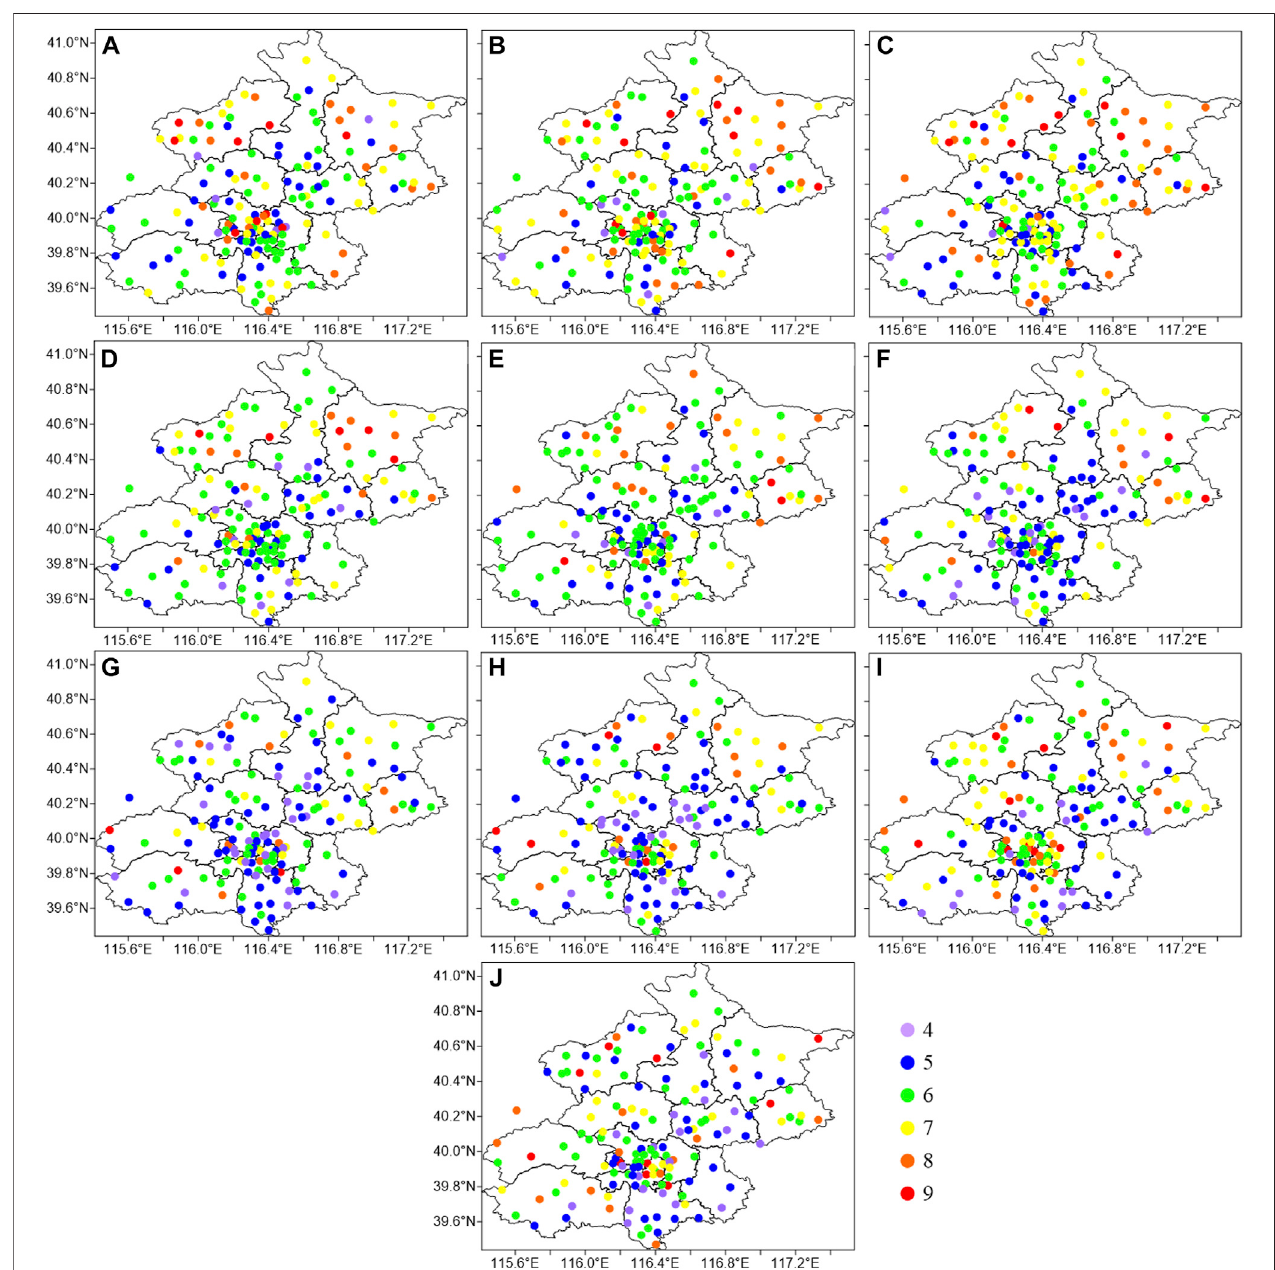
FIGURE 7 | Spatial distribution of typical cluster numbers at different stations in different years. (A – J) 2008 – 2017.